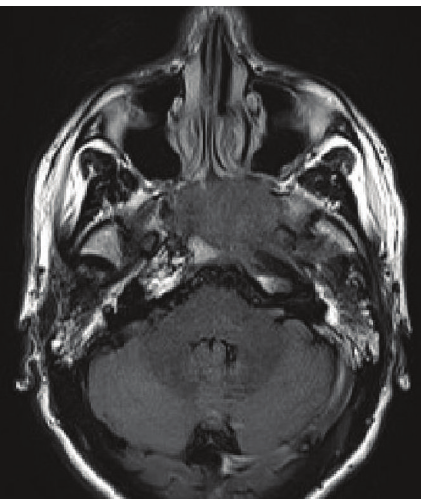
Figure 1: Magnetic resonance imaging of the head and neck revealed a nasopharyngeal mass with extension into the left ptery- gopalatine fossa. Bony involvement of the greater wings of the sphenoid and clivus was described.